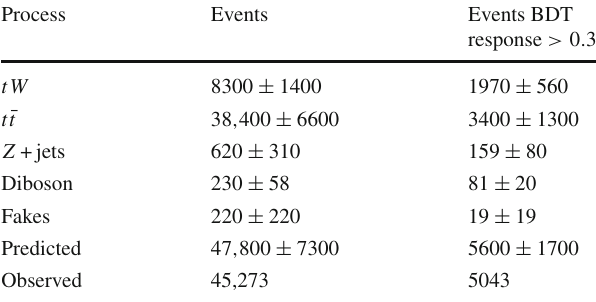
Table 1 Predicted and observed yields in the 1j1b signal region before and after the application of the BDT requirement Process